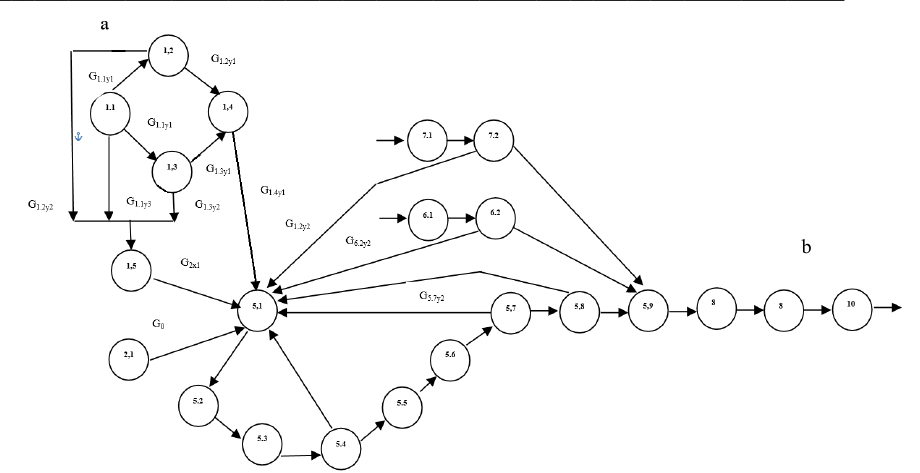
Fig. 4. Low-waste technology module ‘Phosphorus-1’ : а ) Mine, 1.1–1.5 – technological operators of the mine; b) NZPP, 5.1–5.9 – Technological operators of agglomerate production, 6.1–6.2 and 7.1–7.2 – process operators for flux